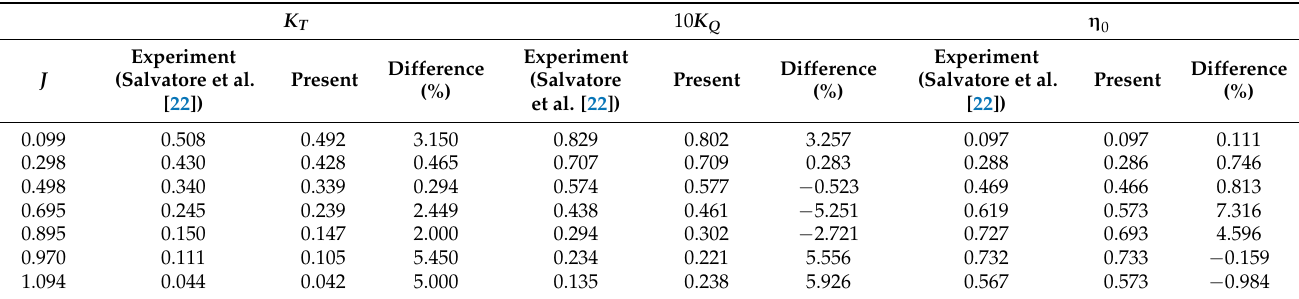
Table 2. Open water test